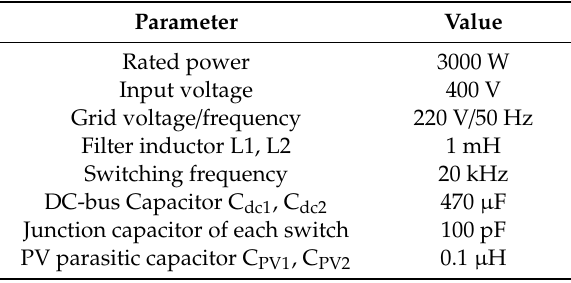
Figure 29. Waveform s of grid current, terminal voltage, CM voltage, and leakage current.